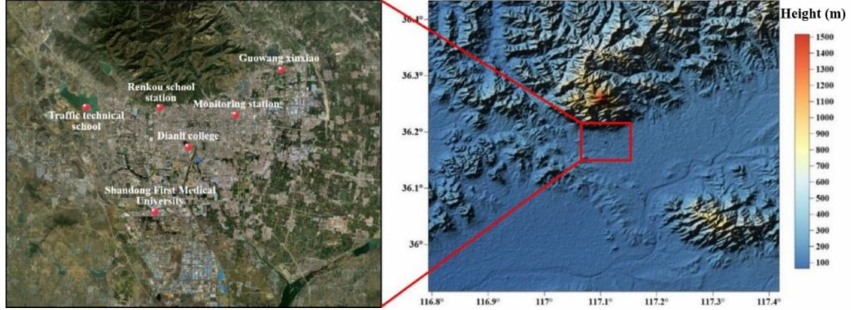
Figure 1. Map of Tai’an and distributions of six air quality monitoring stations in Tai’an.Map data © 2022, Gaode